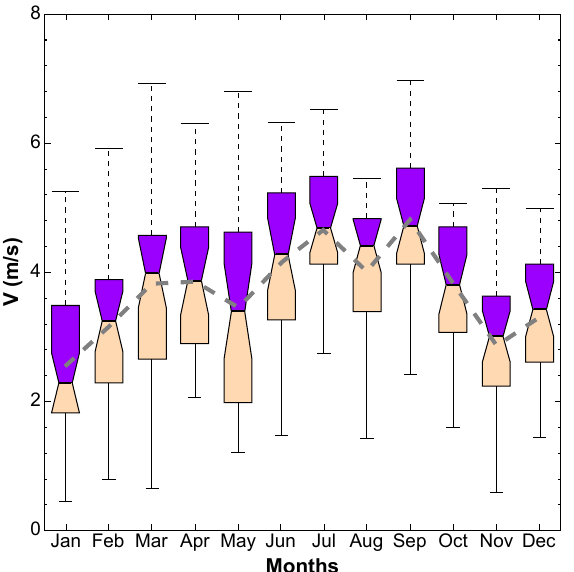
Figure A5. Notched boxplots show the daily variability of wind speed each month; the dashed line shows the mean values.